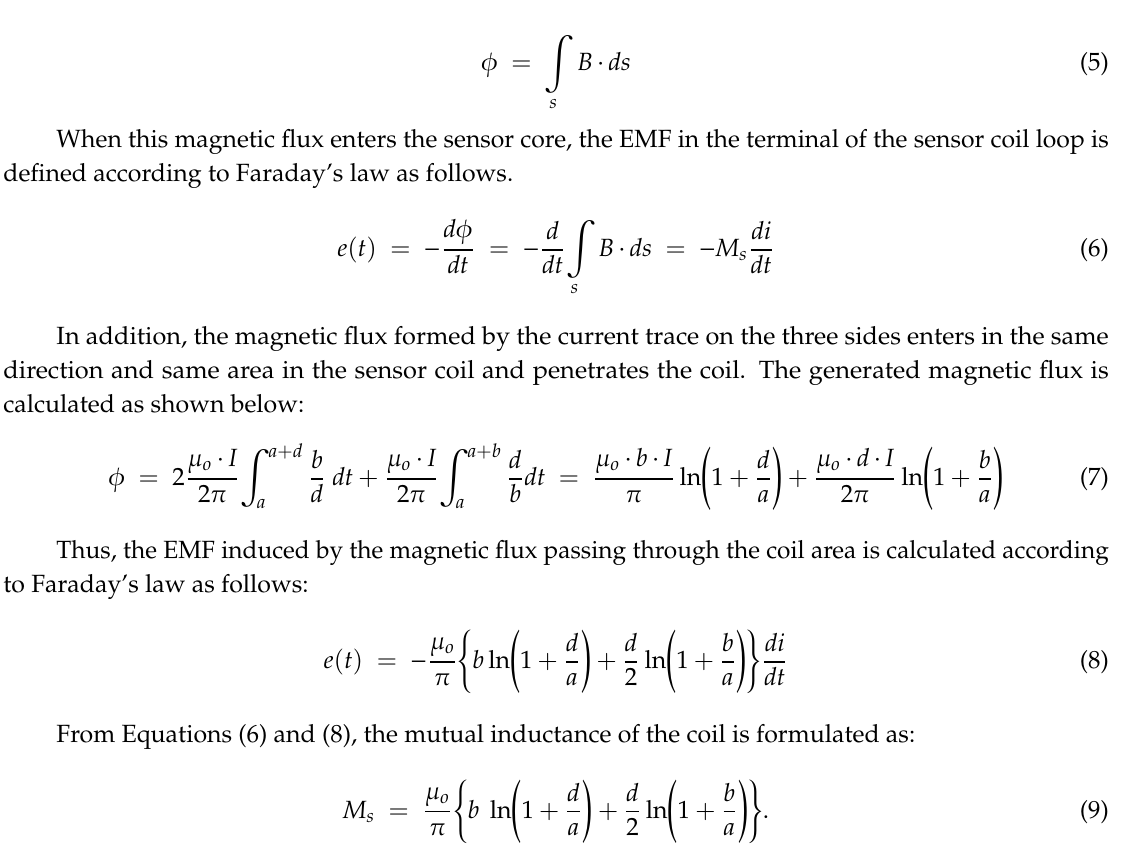
Figure 7. Proposed pick-up coil model: ( a ) equivalent ℼ model; ( b ) geometry of a single coil.